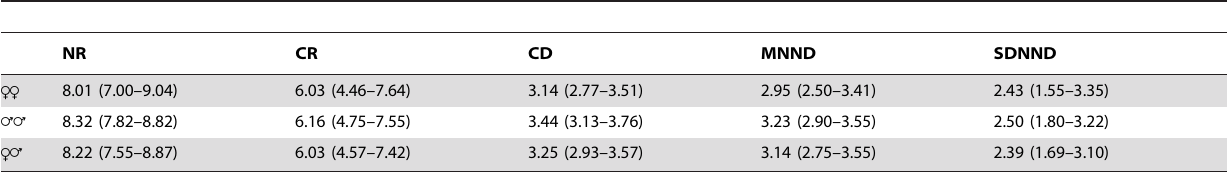
Table 5. Probability values of Layman’s metrics in three simulated model food webs for Rı´o de la Plata region, including only females, males or both sexes in the samples of predators.